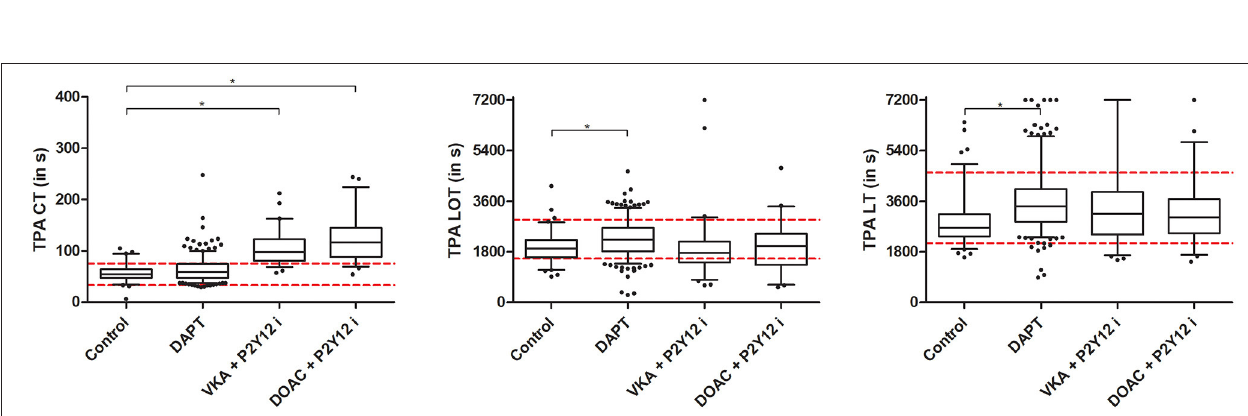
FIGURE 3 | Clotting time (CT), lysis onset time (LOT) and lysis time (LT) tissue plasminogen activator (tPA) ROTEM. Presented are median, IQR and 5–95 percentile whiskers. Dashed lines illustrate tPA ROTEM reference range as determined by Kuiper et al. (20) Significant differences ( p < 0.008) compared to the control group are reported with an